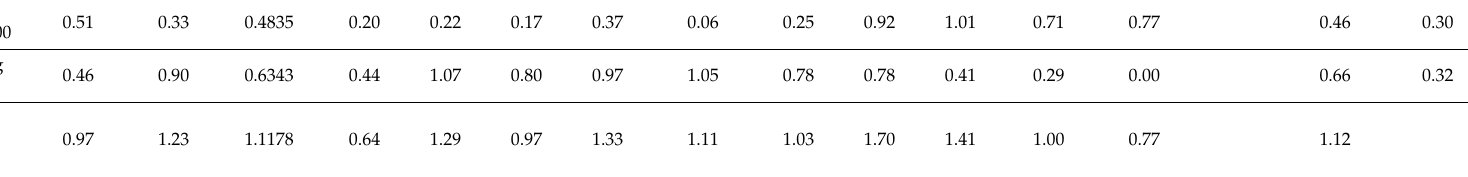
Table 2. The full time equivalent (FTE) personnel per 1000 adults (18+) by provider status (a.), organizational level (b.), local versus centralized services (c.). Catchment Areas * Mental health index (Finland =